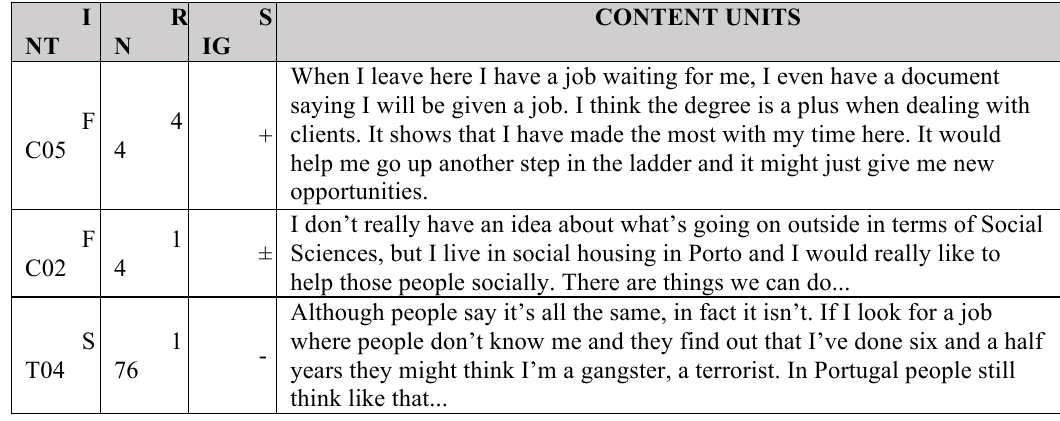
Table 4 . Expectations after completing higher